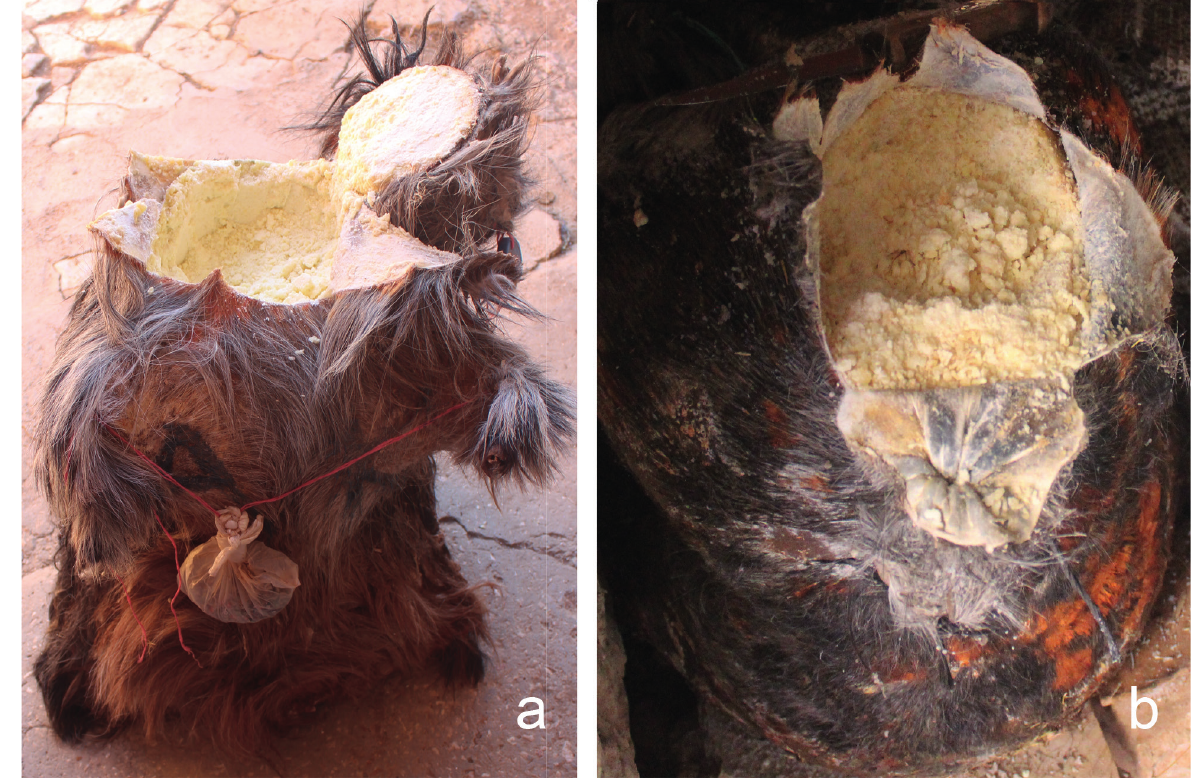
Figure 2 - Photographs of collected Söğle tulum cheeses C1 ( a ) and C4 ( b ) produced in Büyük Söğle and Küçük Söğle